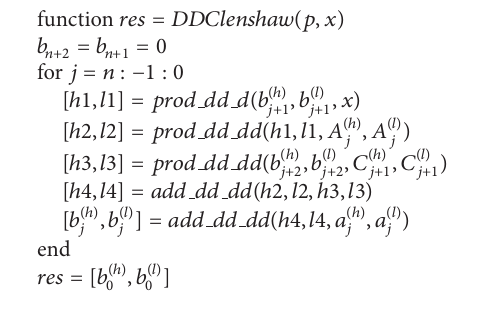
Algorithm 15: DDClenshaw algorithm of evaluating an Legendre series in double-double